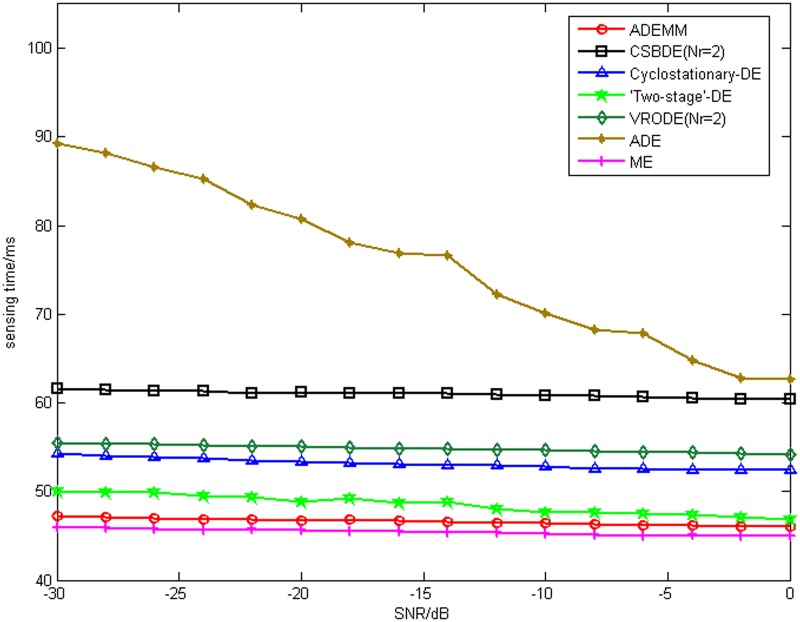
The required sensing time (Pf = 0.1, N = 1000).